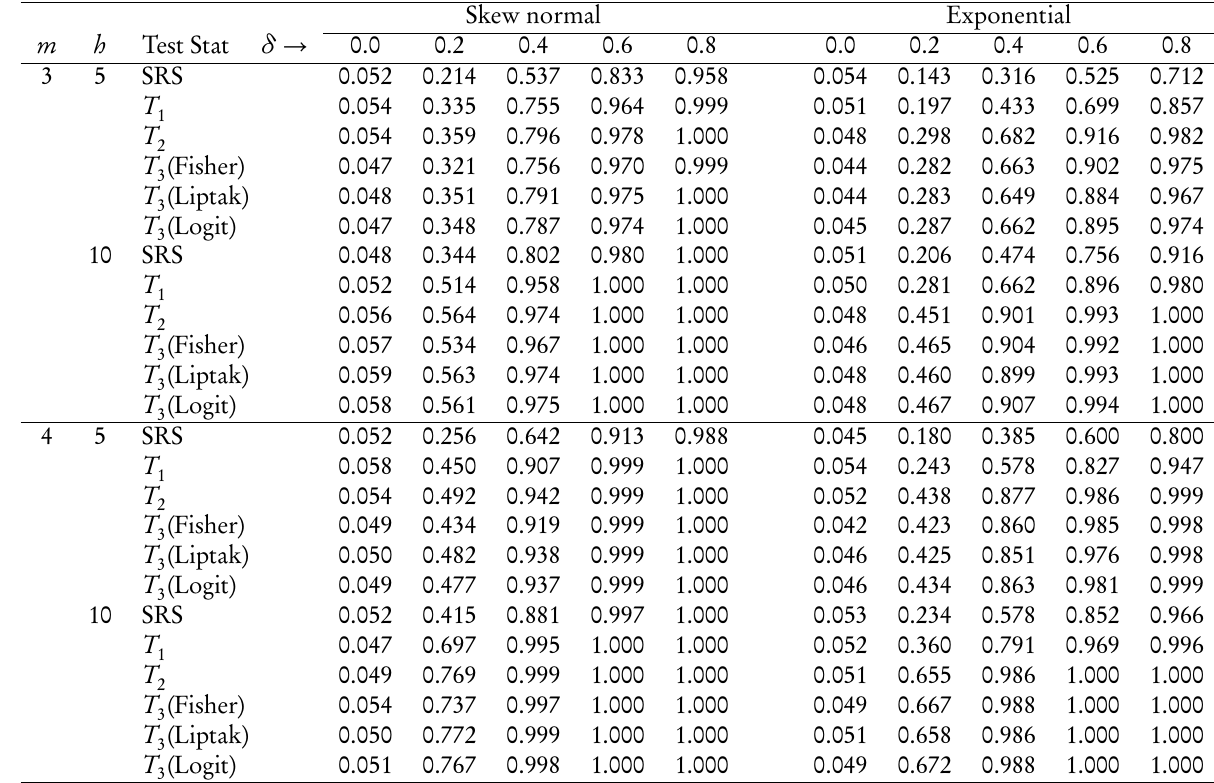
Empirical significance level and power from the simulation study – Skew normal and exponential